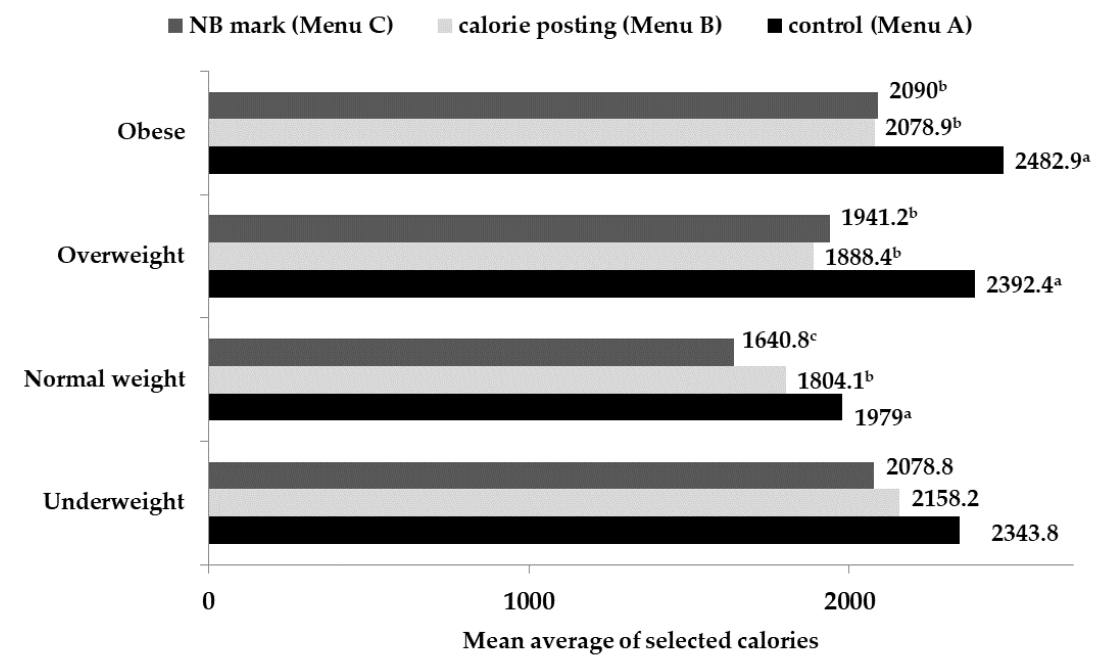
Figure 2. Mean selected calories among the four BMI categories for each menu (NB mark, control, calorie posting). The superscript letters (a,b,c) display the statistically significant differences between the selected calories on each menu per BMI category ( p ≤ 0.001). Table 2. Kruskal–Wallis ANOVA analysis. The superscript letters ( a,b, display the statistically significant differences, with statistical significance set at p level <